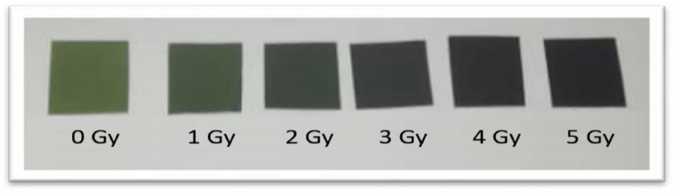
Figure 1. Incremental changes to the color changes of expired EBT3 film. The dark blue color is caused by the properties of the monomer, which changes to blue when exposed to radiation during polymerization [18]. As the dosage of